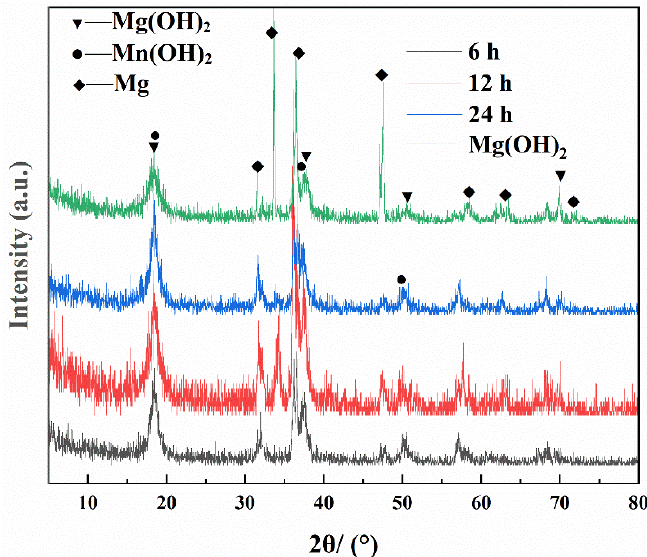
Figure 1. XRD patterns of different samples.